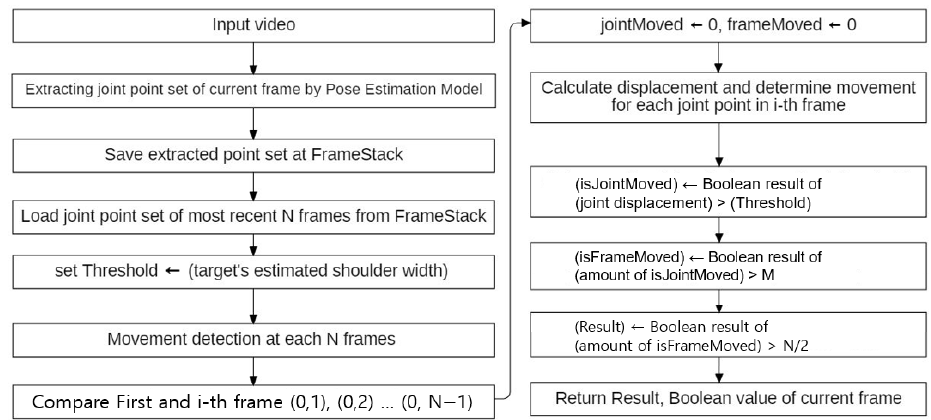
Figure 2. Overall structure of movement detection system in the proposed study. Movenet is used as a skeletal pose-detection model. The Vector Sum Method (VSM), to be discussed in Figure 6, is used as a movement detection algorithm. N represents the parameter RecentFrame in this flowchart. M represents parameters for ignoring single-joint movement, and N/2 represents the majority number of recent frames for detection